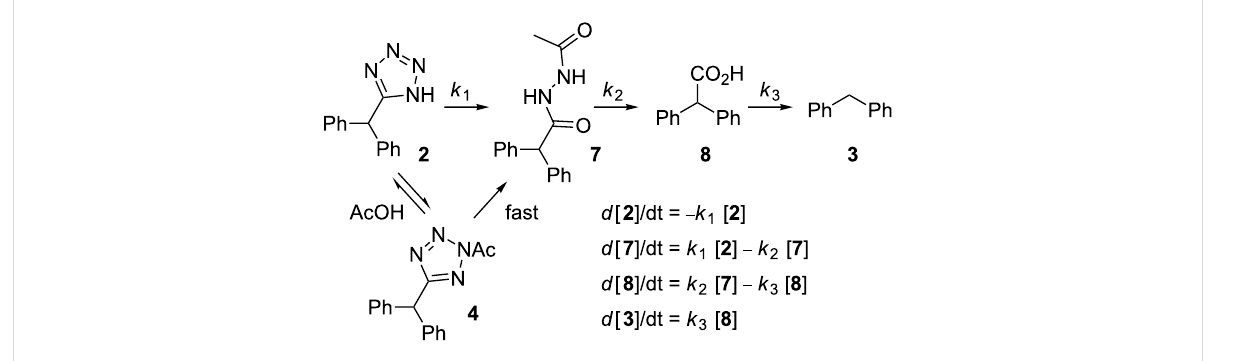
Scheme 3: Reaction steps for the degradation of tetrazole 2 and the corresponding rate